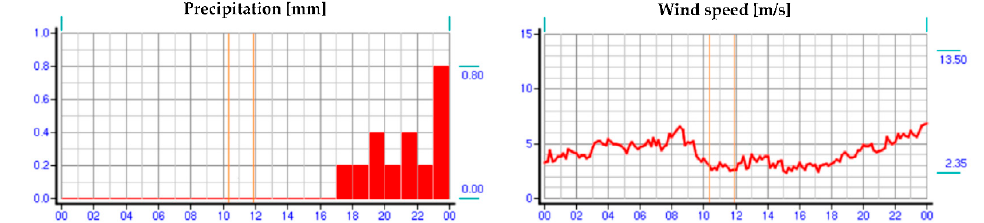
Figure 5. Precipitation and wind speed values on the day of the study (source: authors).